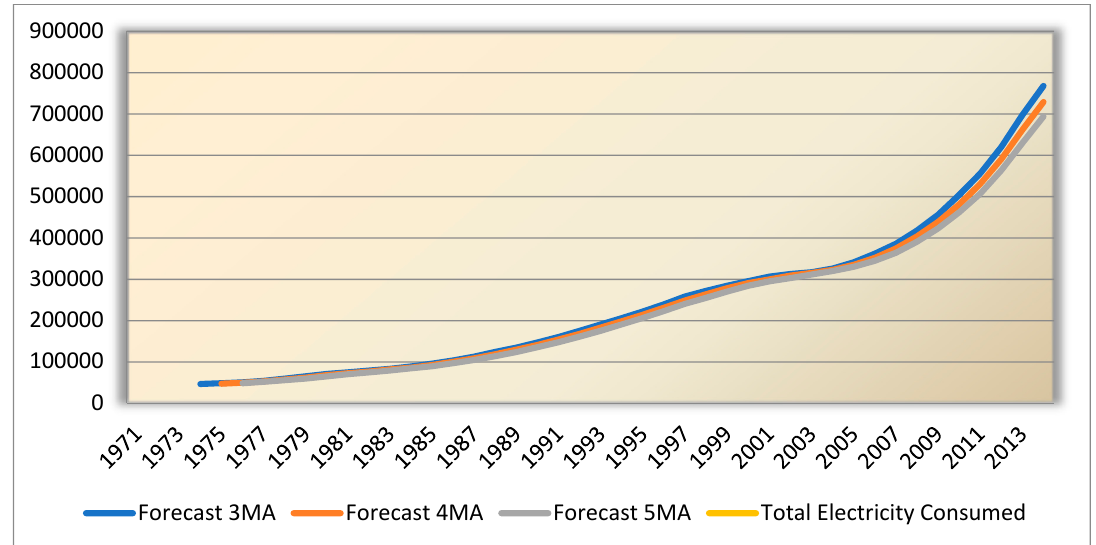
Figure 9. Chart for moving average method (1971–2014).